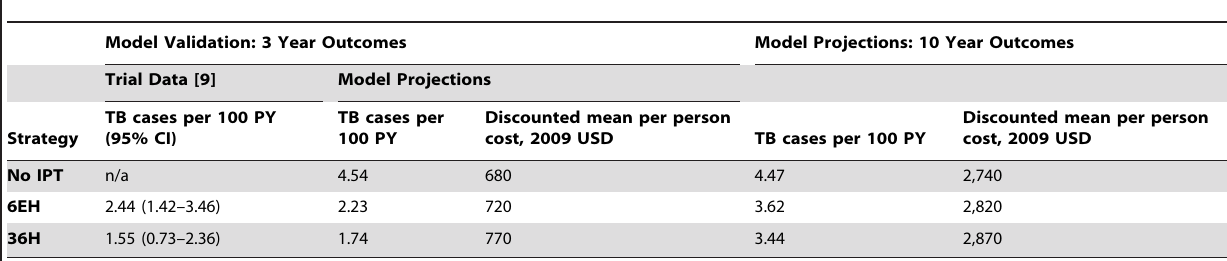
Table 4. Model validation and 10-year outcomes for TB incidence and cost of 6EH and 36H compared to no